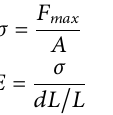
FIGURE 5 | Tensile test curves of samples.